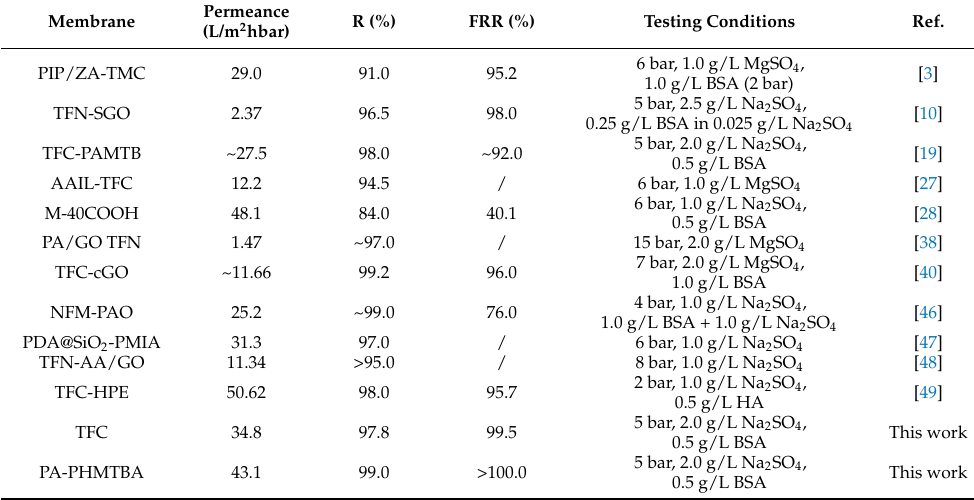
Table 3. Performance comparison of prepared membrane with other NF membranes reported in the